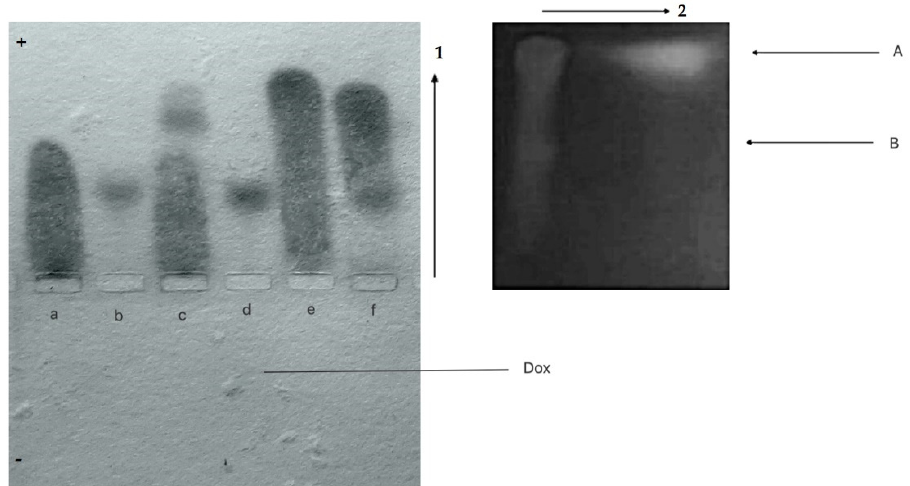
Figure 5. The possibility of creating complexes between L λ and CR-Dox (2:1 molar ratio) was analyzed—replica on filter paper applied to bromophenol blue stained gel (after agarose gel electrophoresis at pH 8.6); migration towards the anode (+): ( a ) CR, ( b ) L λ , ( c ) L λ -CR complex, ( d ) L λ -Dox mixture (Dox can be seen as migrating towards the cathode (-), pointed by arrow), ( e ) CR-Dox (molar ratio 2:1), ( f ) L λ -CR-Dox (CR-Dox molar ratio 2:1); The absence of Dox in the L λ -CR-Dox mixture was confirmed chromatographically. Arrow ( A ) points to Dox eluted from CR-Dox complex (fastest migration), arrow ( B ) points to the position of L λ − CR complex (where Dox is absent).